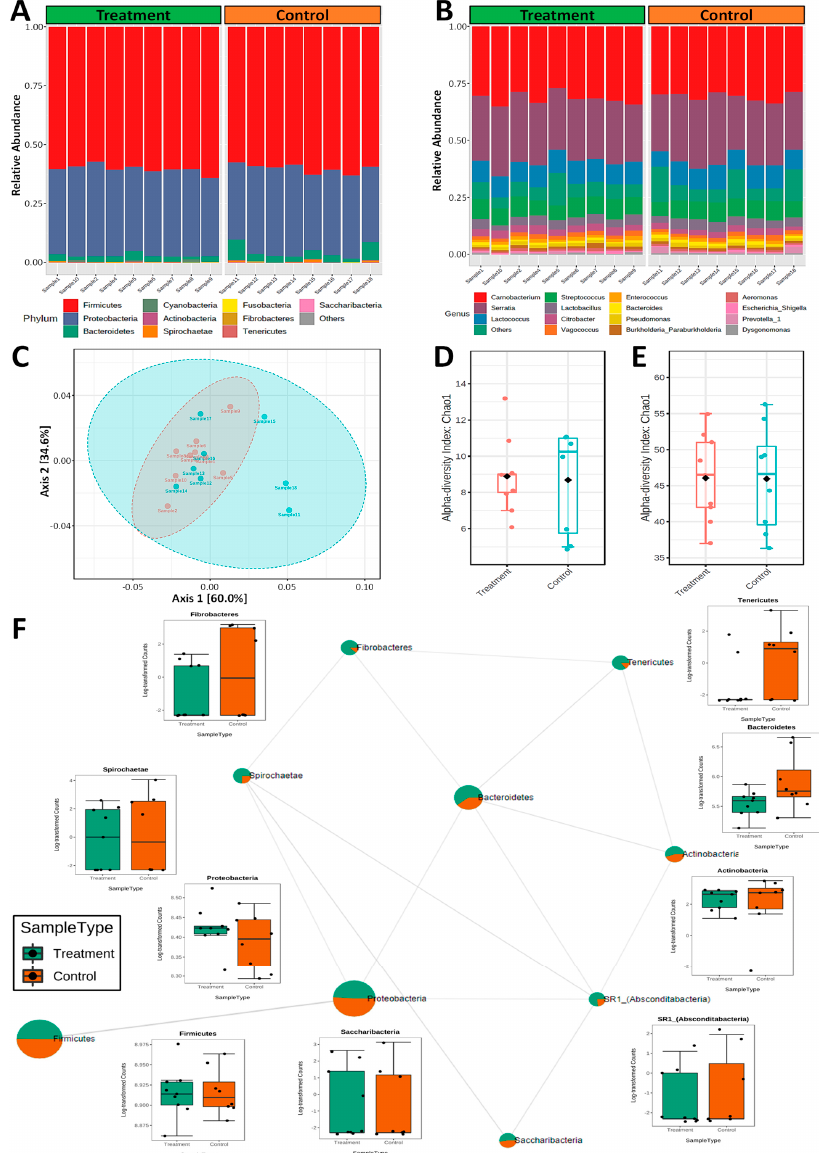
Figure 3. Microbial composition and profiling of adult male nematodes from vaccine-treated and control animals. Each sample is derived from a pooled mixture of ten adult male nematodes taken from the ovine abomasum at postmortem. Phyla constituting less than 1% of the total phylum distribution for a sample were labelled ‘Others’. Top ten phyla ( A ) and fifteen genera ( B ) level features correlated with the control or vaccine-treated groups. ( C ) Phylum-level Bray-Curtis dissimilarity correlations of the treatment (red) and control (blue) nematode microbiomes. Alpha diversity boxplots showing Chao1 species richness determined using the Mann-Whitney U test at the phylum ( D ) and genus ( E ) level of treatment (red) and control (blue) microbiomes. Co-abundance groups interaction network based on the relative abundance of bacterial phyla in nematodes from vaccinated (green) and non-treated control (orange) animals ( F ). Node size represents the average abundance of each OTU with lines between nodes representing the correlations to each other. The corresponding boxplots show log-transformed counts for each phylum. In each plot, the box represents the interquartile range, the line inside the box represents the median, and the whiskers denote the minimum and maximum